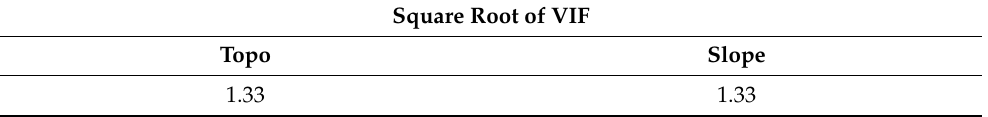
Table 2. The variance inflation factor of independents variables (topography and